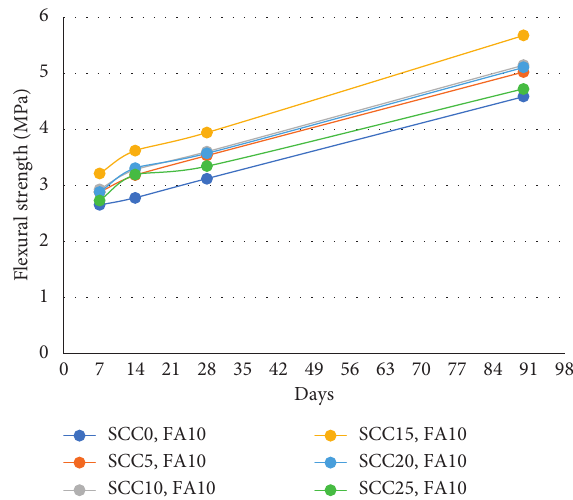
Figure 9: Flexural strength test results for concrete mixes with 10% replacement of fly ash.